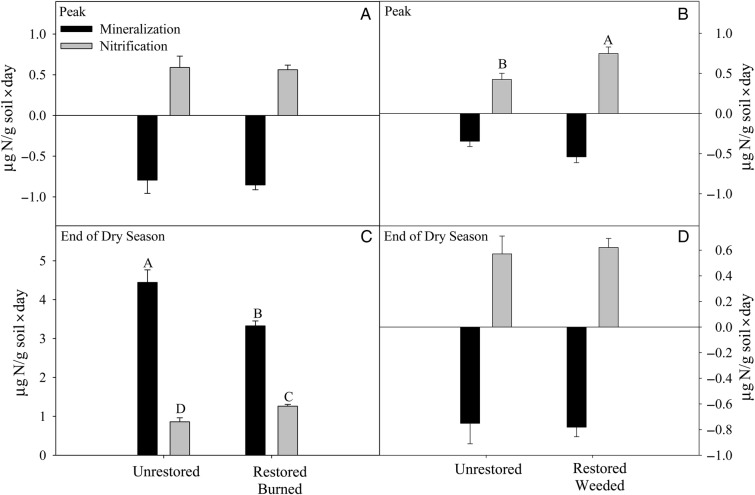
Potential N mineralization and nitrification from 30-day laboratory incubations from the inland site (A and C) and the coastal site (B and D) for soils collected in the March (peak) and August (end of the summer dry season) of 2008. Letters indicate significant differences using the Tukey–Kramer HSD test following ANOVA (P ≤ 0.05). Bars indicate standard error.